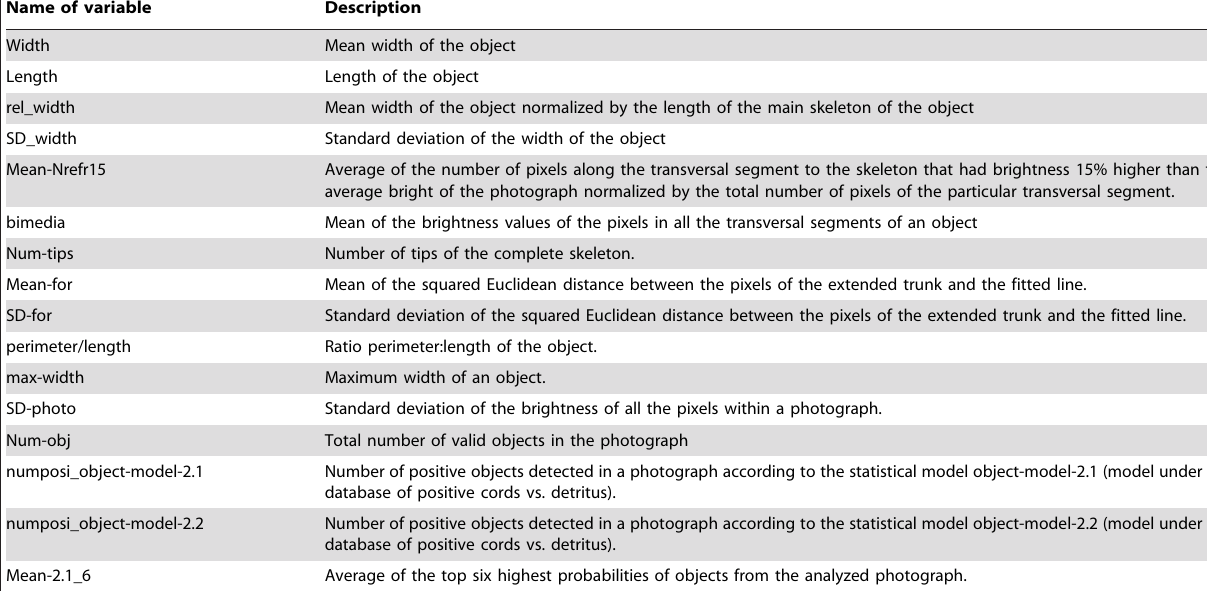
Name of variable